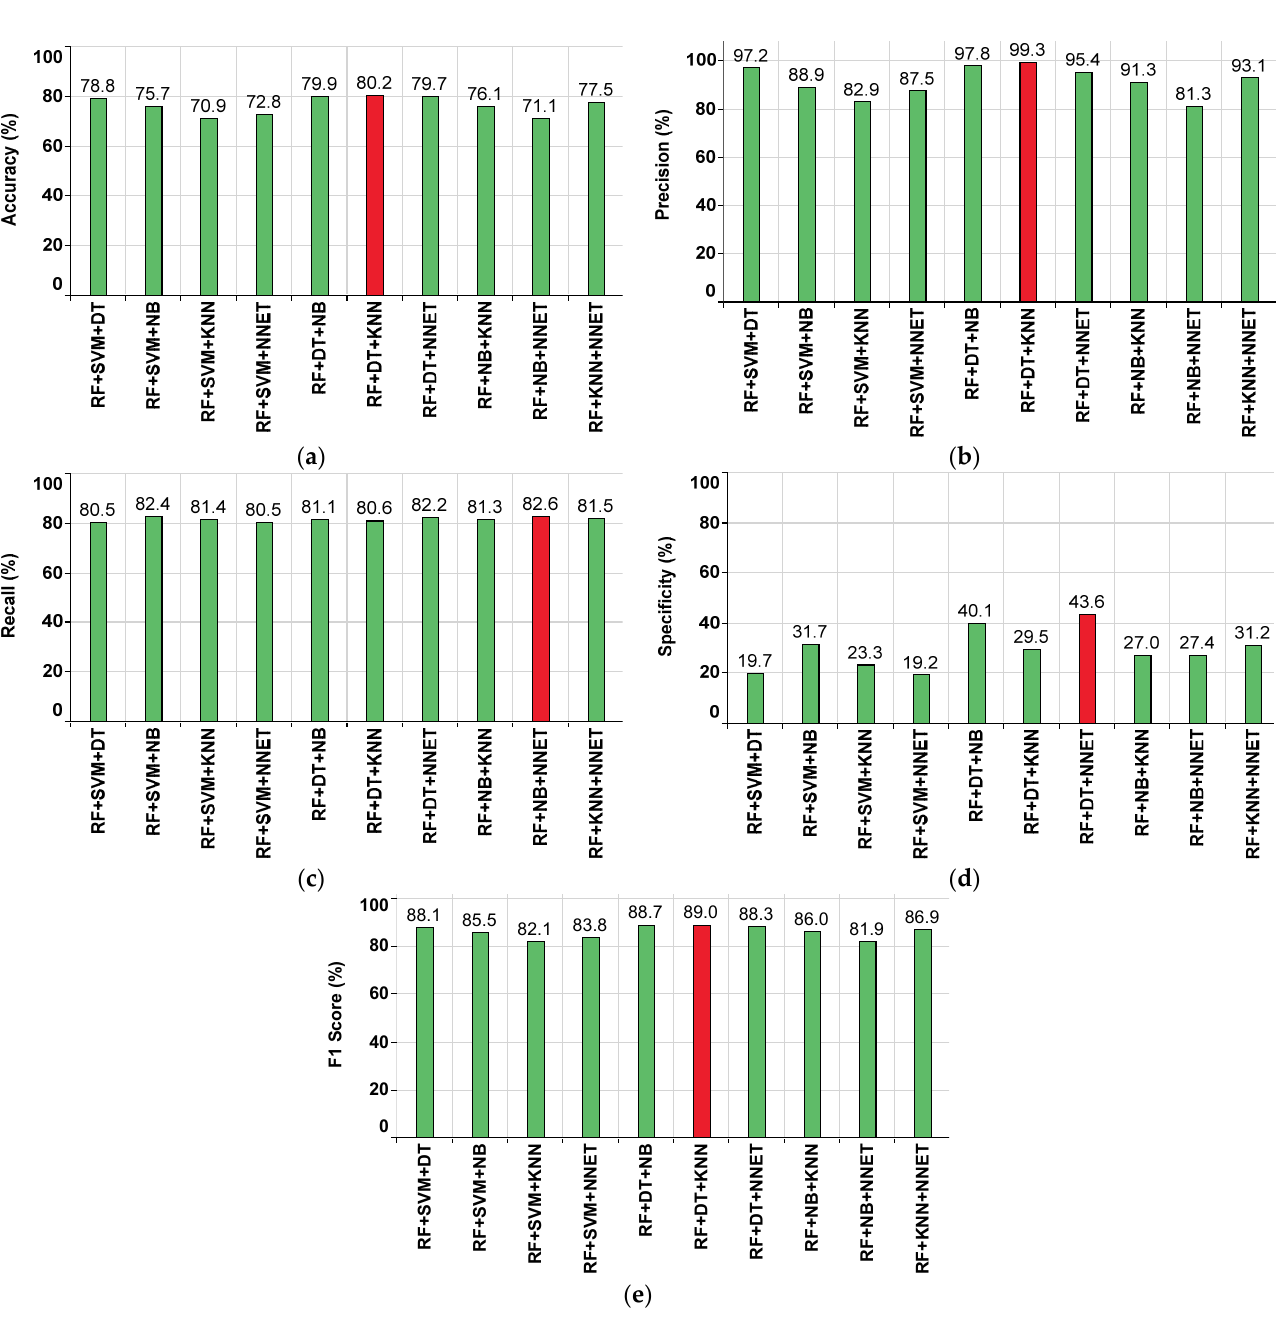
Figure 11. Performance metrics for the ensemble classifiers approach on the KNN imputed dataset. ( a ) Accuracy. ( b ) Precision. ( c ) Recall. ( d ) Specificity. ( e ) F1 Table 5. Performance comparison of the ensemble classifiers approaches on the KNN imputed da- taset.